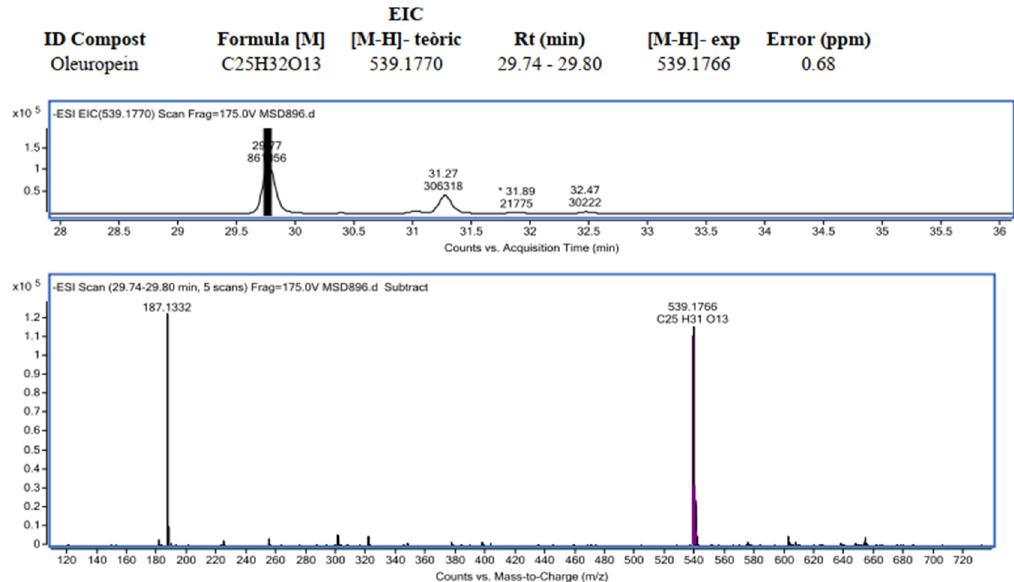
Figure 6. Example of the spectrum (TIC) ESI - TOF (-) of oleuropein.